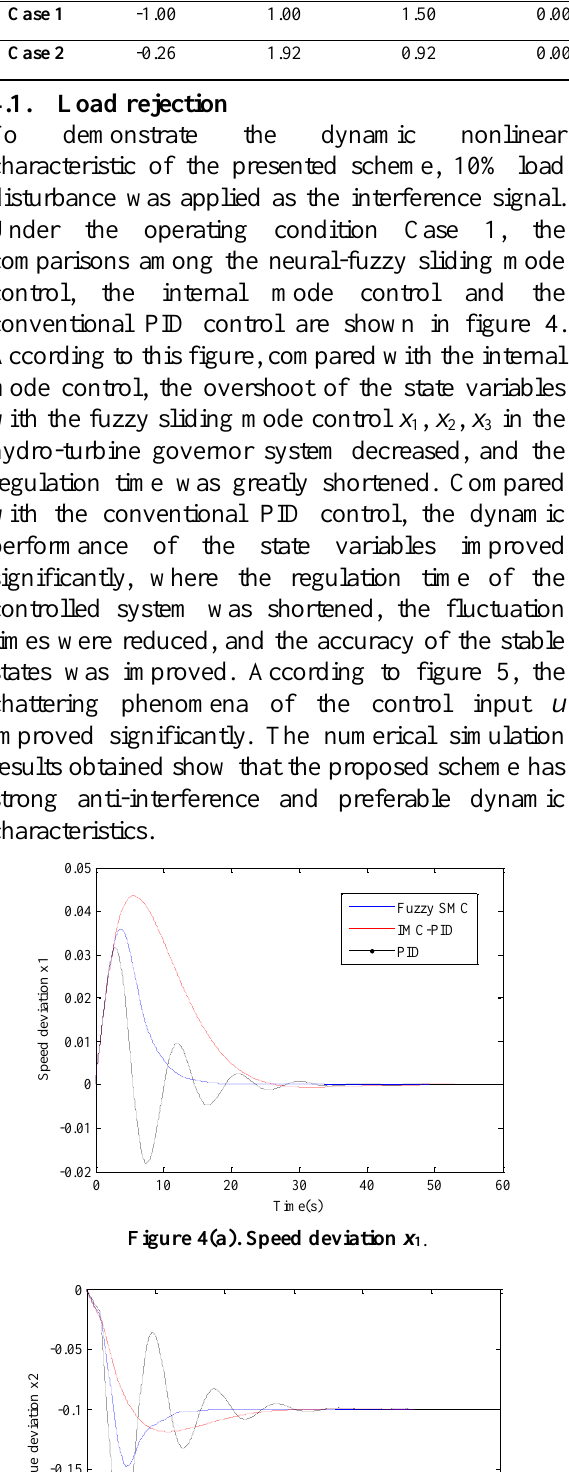
Figure 4(b). Torque deviation x 2.